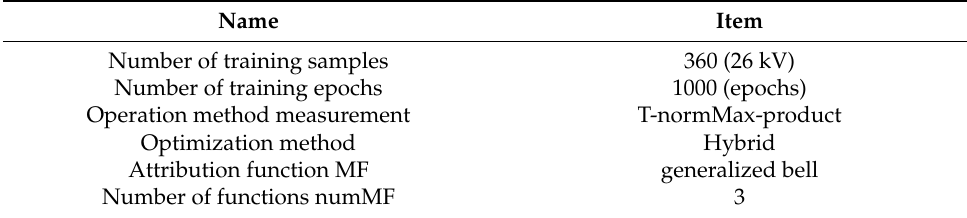
Figure 26. Standard deviation–recognition rate curve for the recognition threshold. ( a ) Defect type 1 (take Feature-1 as an example). ( b ) Defect type 2 (take Feature-93 as an example). ( c ) Defect type 3 (take Feature-97 as an example). Table 6. ANFIS training setup